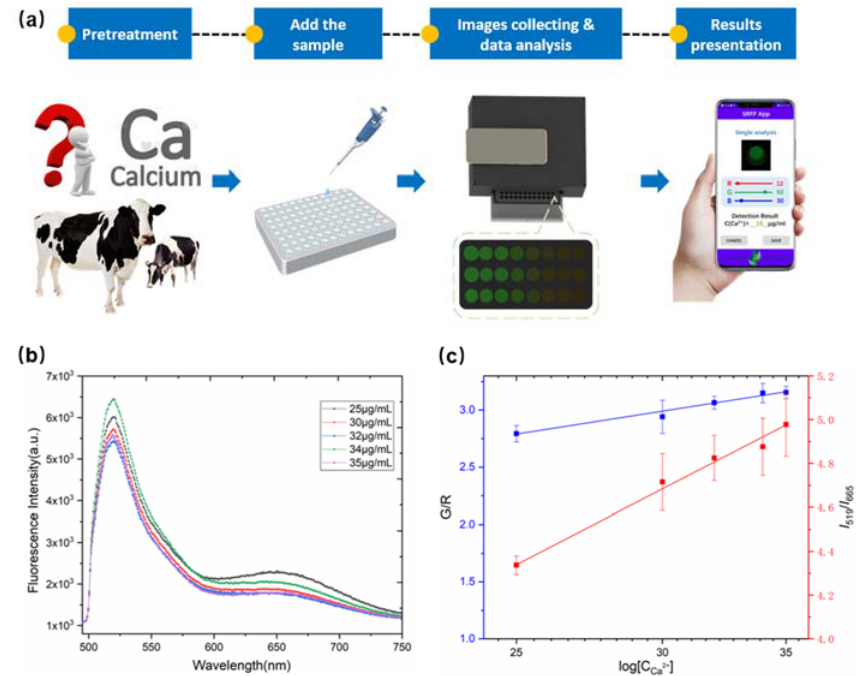
Figure 6. ( a ) Schematic illustration of the SRFP system and the application of detection of Ca 2+ in bovine serum. ( b ) Fluorescence spectra of bovine serum with different levels of Ca 2+ with ratiometric fluorescent probes. ( c ) A linear relationship between the ratio of G/R channel (blue line) and the fluorescence intensity ratio I 519 /I 665 (red line) and different concentrations of Ca 2+ . Tests were performed in triplicate. Error bar indicates mean ± standard deviation for three measurements at different places. Table 2. Comparison results of bovine serum calcium detection using fluorescence detection method and SRFP platform.